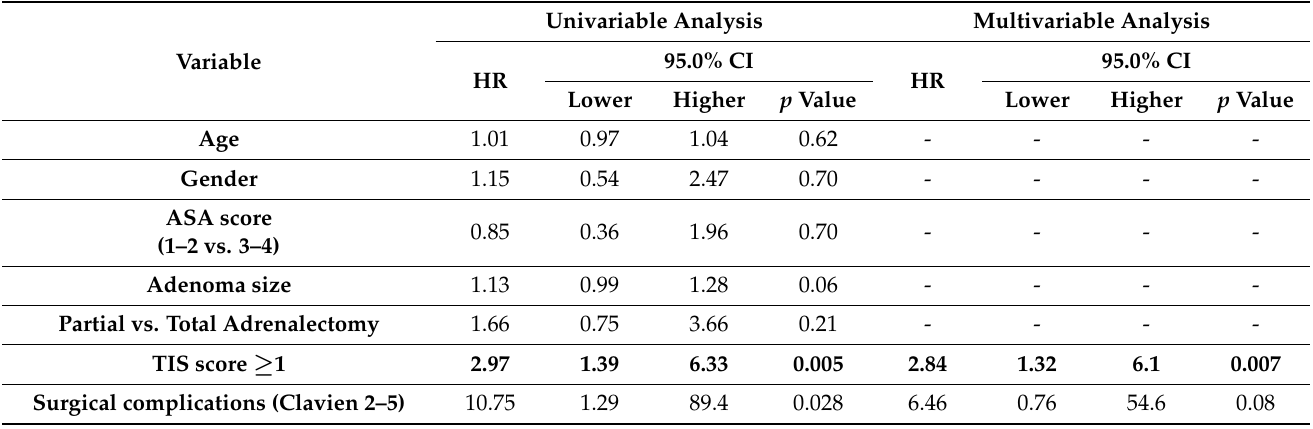
Table 5. Univariable and multivariable Cox regression analysis to identify predictors of partial and absent clinical